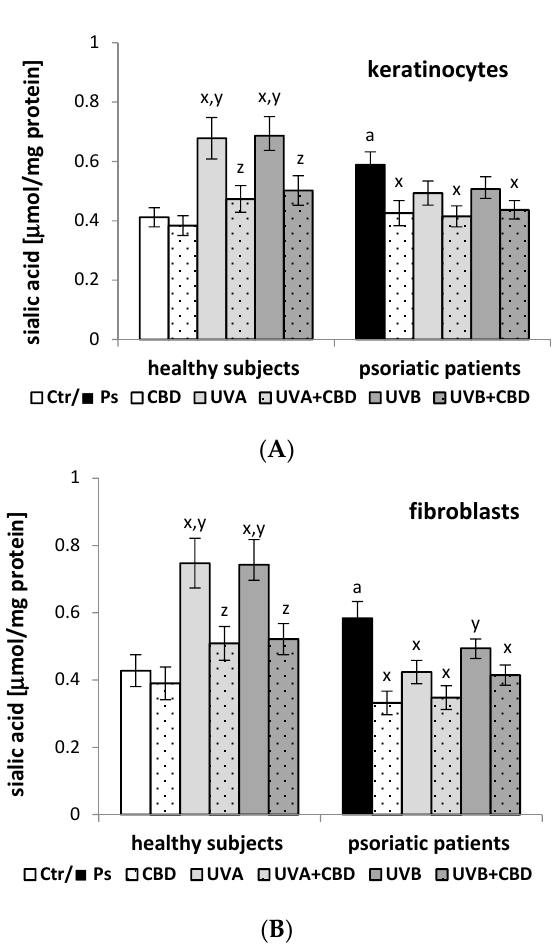
Figure 2. The sialic acid content in keratinocytes ( A ) and fibroblasts ( B ) isolated from skin of healthy subjects (Ctr) ( n = 6) and psoriatic patients (Ps) ( n = 6) exposed to UVA (30 J/cm 2 ) and UVB (60 mJ/cm 2 ) radiation as well as untreated and treated with cannabidiol (CBD) (4 µ M). The mean values ± SD and statistically significant differences for p < 0.05 are presented.; a —differences between Ps and Ctr groups; x —differences vs. Ctr or Ps group; y —differences vs. CBD treated groups [CBD and Ps + CBD]; z —differences vs. UVA or UVB treated groups [UVA/UVB and Ps + UVA/UVB]. Both the development of psoriasis and the UV irradiation of skin cells are accompanied by a redox equilibrium shift towards oxidative conditions, the consequence of which is an increase in the level of the lipid peroxidation product MDA in keratinocytes and fibroblasts of patients with psoriasis (Figure 3). Both UVA and UVB radiation increased the MDA level in skin cells from healthy people and psoriatic patients. The administration of CBD after UVA/B irradiation decreased the MDA level in both keratinocytes and fibroblasts from healthy people and psoriatic patients in comparison to irradiated cells without CBD treatment. The changes observed in keratinocytes from psoriatic patients were